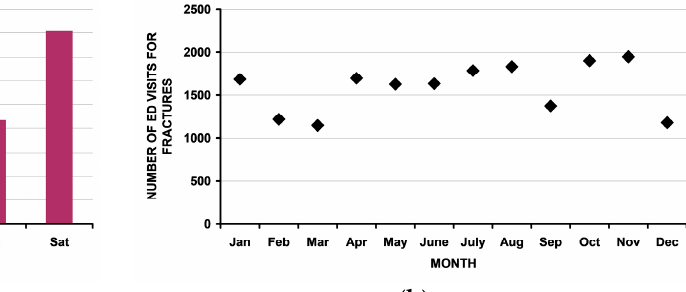
Figure 5. Di ff erences by disposition from the ED: ( a ) by race ( p = 0.011); ( b ) by perpetrator of the injury ( p = 0.0006); ( c ) by intent of the injury ( p < 10 − 4 ); ( d ) by year time span ( p = 0.004).